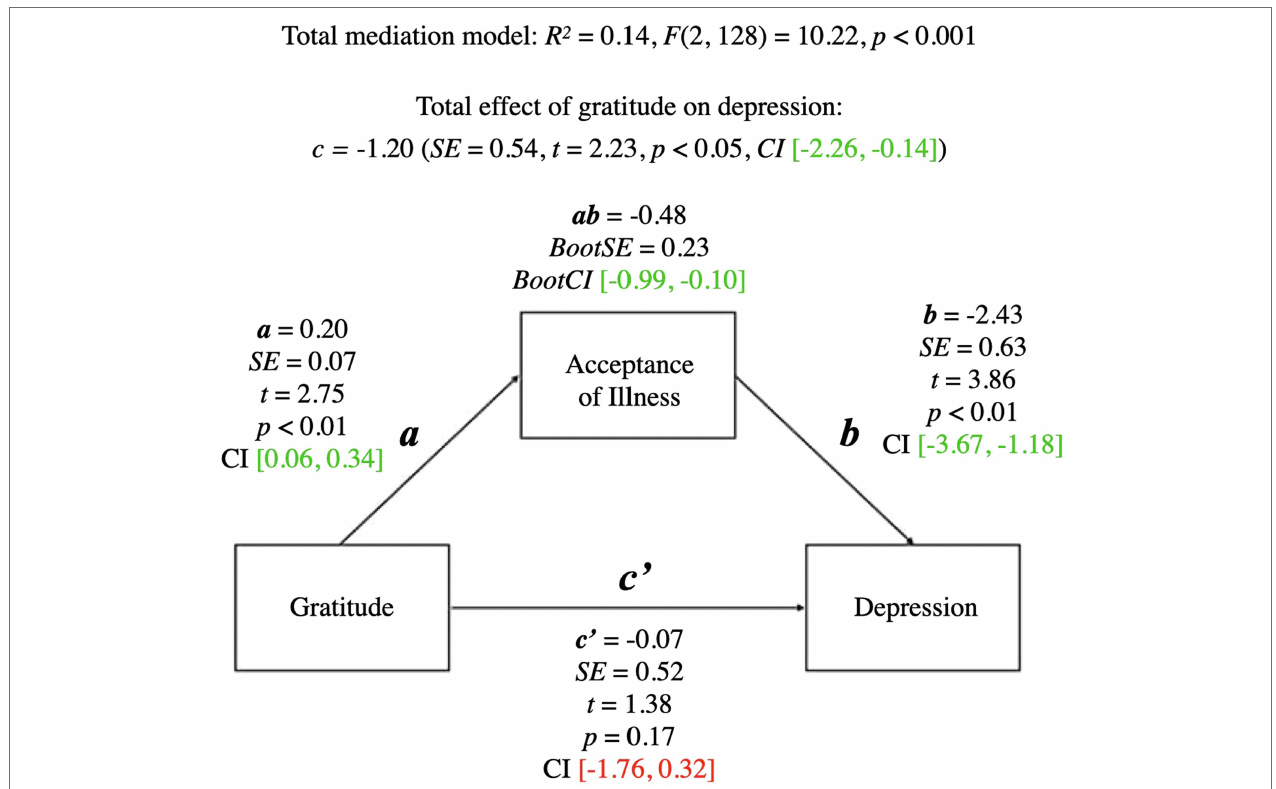
FIGURE 3 | Mediation model for gratitude and depression. a, effect of Gratitude on Acceptance of Illness; b, effect of Acceptance of Illness on Depression; ab, indirect effect of Gratitude on Depression; c', direct effect of Gratitude on Depression; c, total effect of Gratitude on Depression (ab + c'); CI, confidence intervals; CI marked green indicate significance; red – lack of significance.